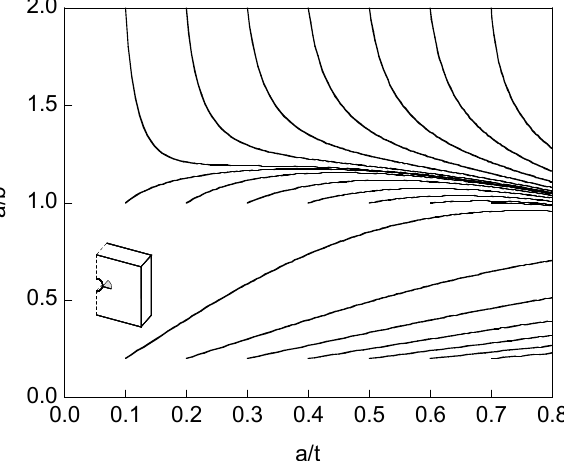
Figure 5. Crack aspect ratio evolution during fatigue propagation in air for cracks emanating from a hole with r = 0.5 t .